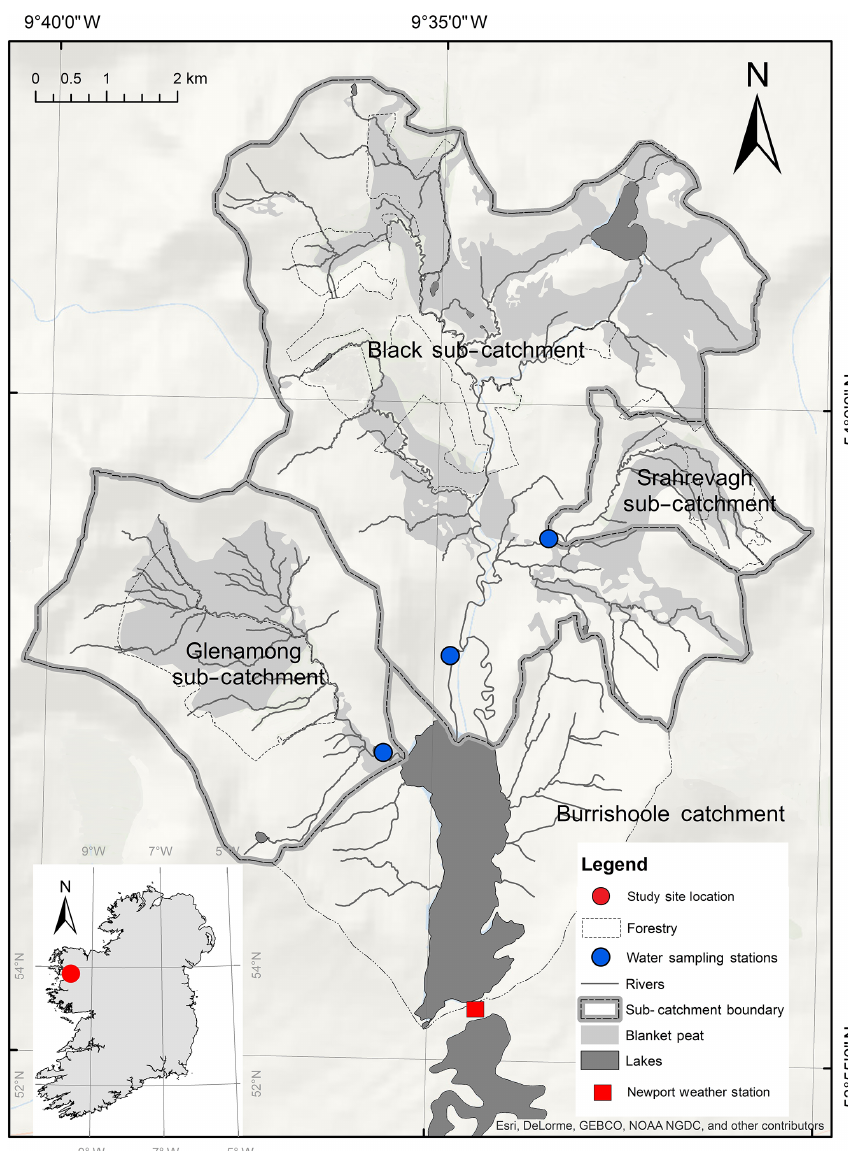
Figure 1. Location of the sub-catchments in the Burrishoole